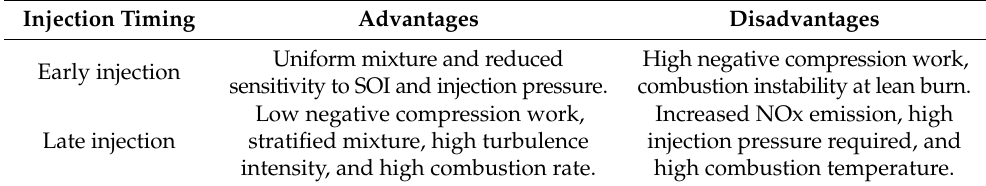
Table 2. Advantages and disadvantages of different injection